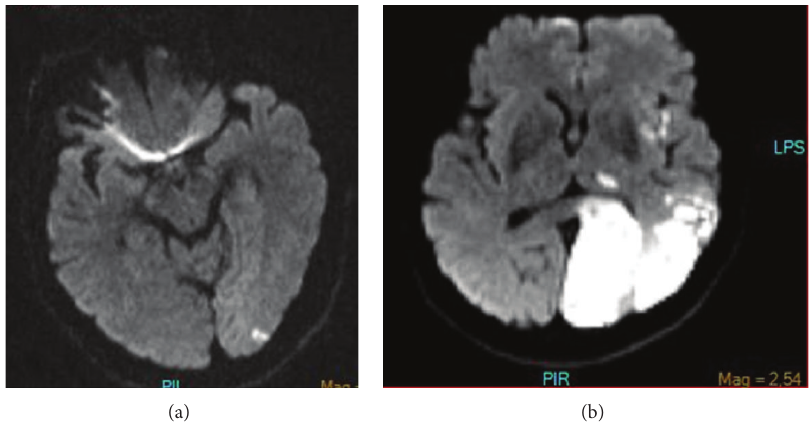
Figure 1: (a) Diffusion MRA showed small infarct on left posterior cerebral artery territory. (b) Diffusion MRA showed large infarct on left posterior cerebral artery territory and multiple infarcts areas on left middle cerebral artery territory.